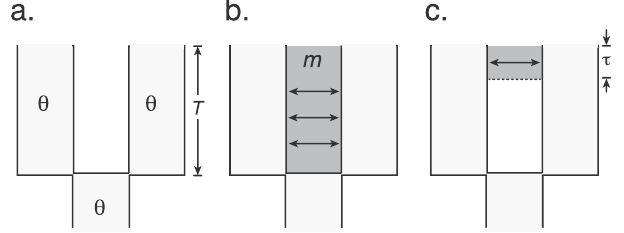
Figure 2. Evolutionary models considered for X . gilli sequence data from east and west populations included ( a ) population division without subsequent gene flow, ( b ) separation followed by ongoing gene flow, and ( c ) separation followed by secondary contact after a period of no gene flow. Model parameters include the population polymorphism parameter θ , which is assumed to be constant in the ancestral and both descendant populations, the time of speciation T , the amount of migration m , and the time of secondary contact τ